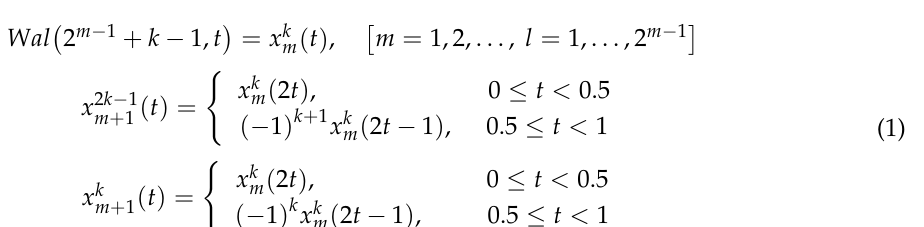
Figure 8. Block diagram of